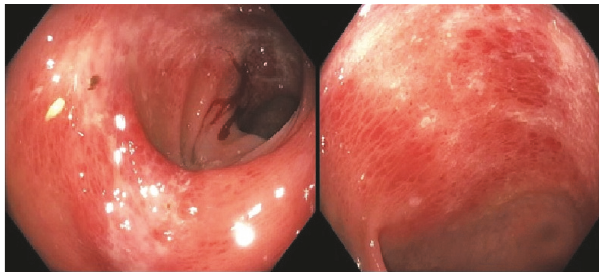
Figure 2: Colonoscopy demonstrating segmental moderate inflam- mation in the sigmoid colon, descending colon, and splenic